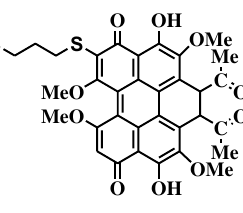
Fig. 4. The structure of 2 .